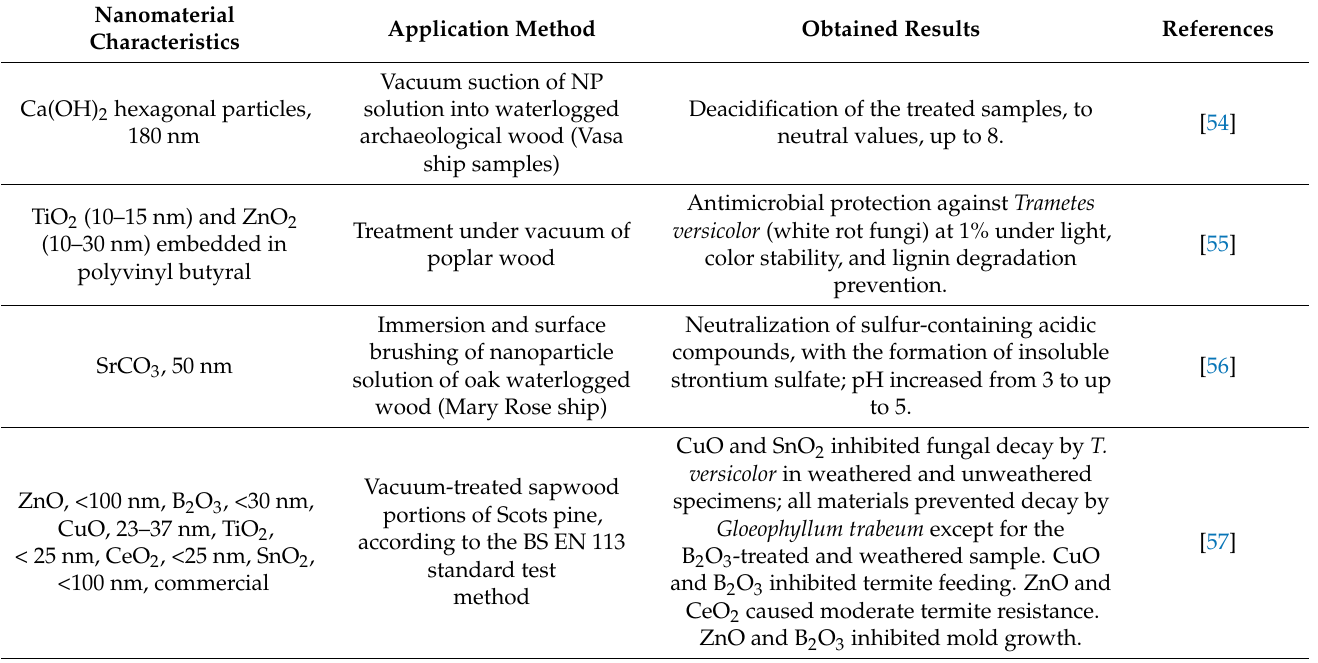
Table 2. Application of inorganic nanomaterials for the treatment of historical wood (references presented in chronological